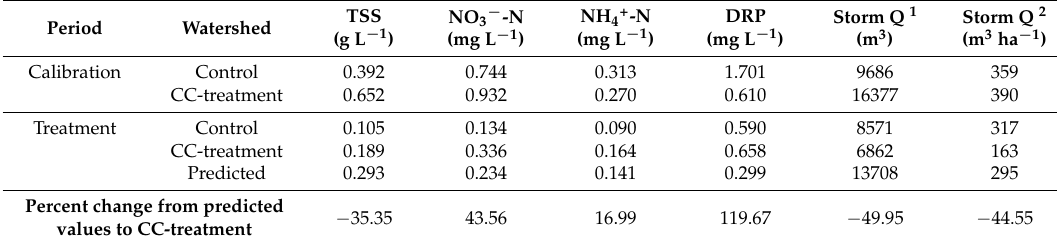
Table 7. Event mean concentrations representing 28 storm events collected during the calibration period from November to May and 7 during the CC-treatment period (Cereal Rye). Predicted values are calculated from the equations in Table 4.